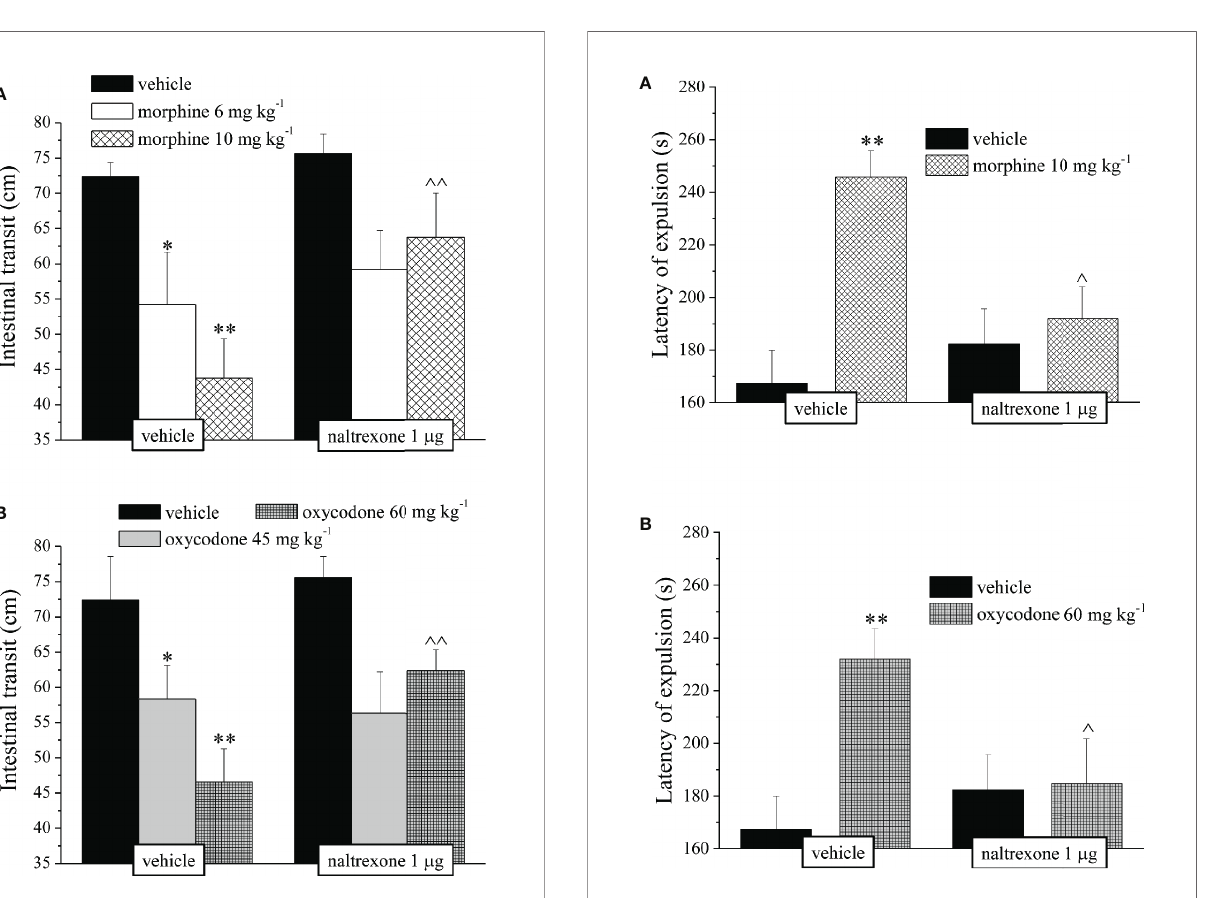
FIGURE 4 | Effect of intranasal administration of naltrexone on morphine and oxycodone induced inhibition of intestinal peristalsis in the mouse. Intestinal transit was expressed as the ratio between the distance traversed by the charcoal meal and the total length of the intestine itself. Naltrexone 1 m g was intranasally administered 30 min before the intraperitoneal injection of (A) morphine (6 and 10 mg kg − 1 ) or (B) oxycodone (45 and 60 mg kg − 1 ). Behavioral measurements were performed 30 min after opioid treatment. Control animals were treated with vehicles. Each value represents the mean of 10 mice per group, performed in two different experimental sets. *P < 0.05 and **P < 0.01 vs vehicle-treated animals; ^^P < 0.01 vs morphine or oxycodone-treated animals.